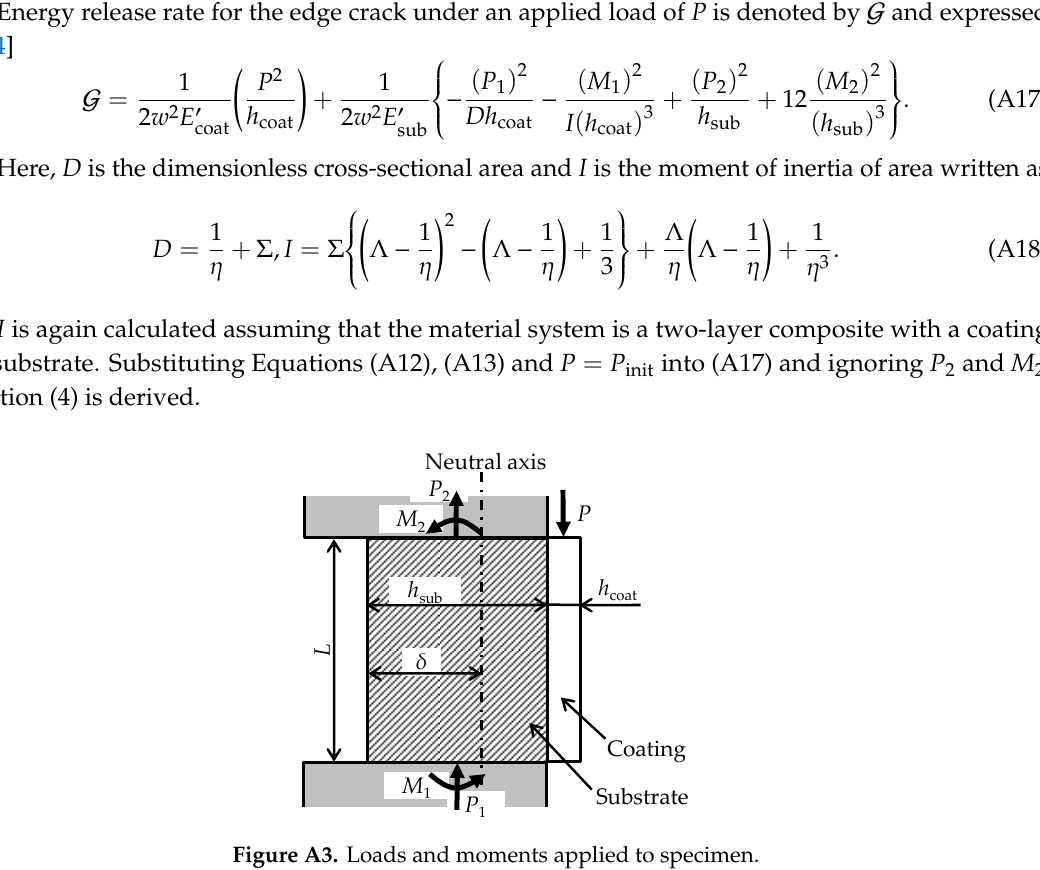
Figure A3. Loads and moments applied to specimen.